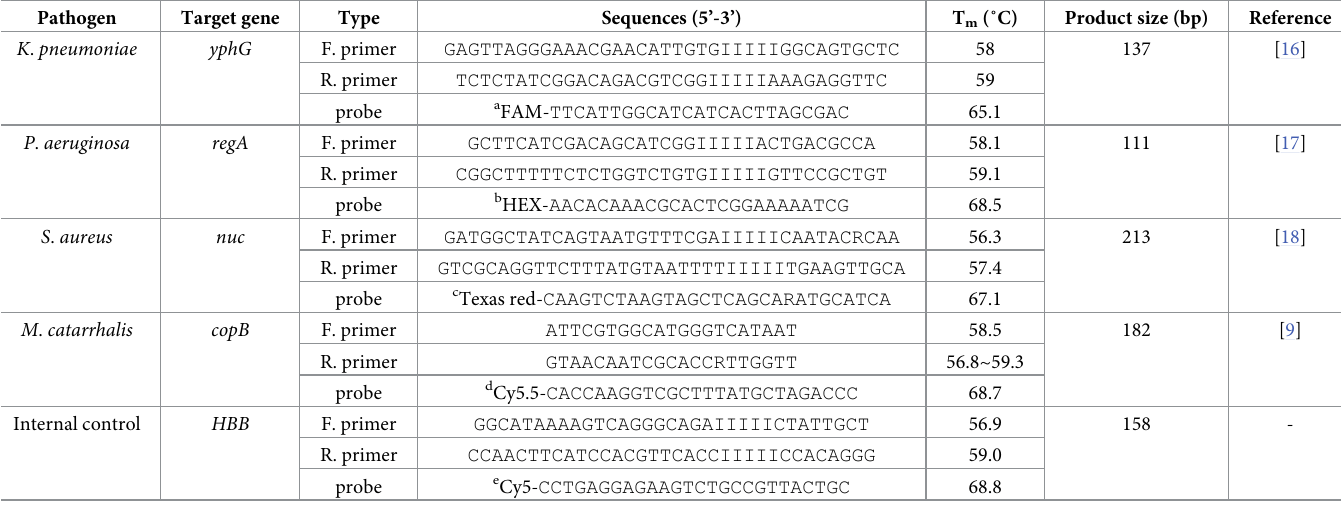
Probes were labeled with FAM, HEX, Texas red, Cy5.5, and Cy5 and detected at 520, 556, 616, 694, and 669 nm, respectively. All the probes were had BHQ as a quencher at 3’